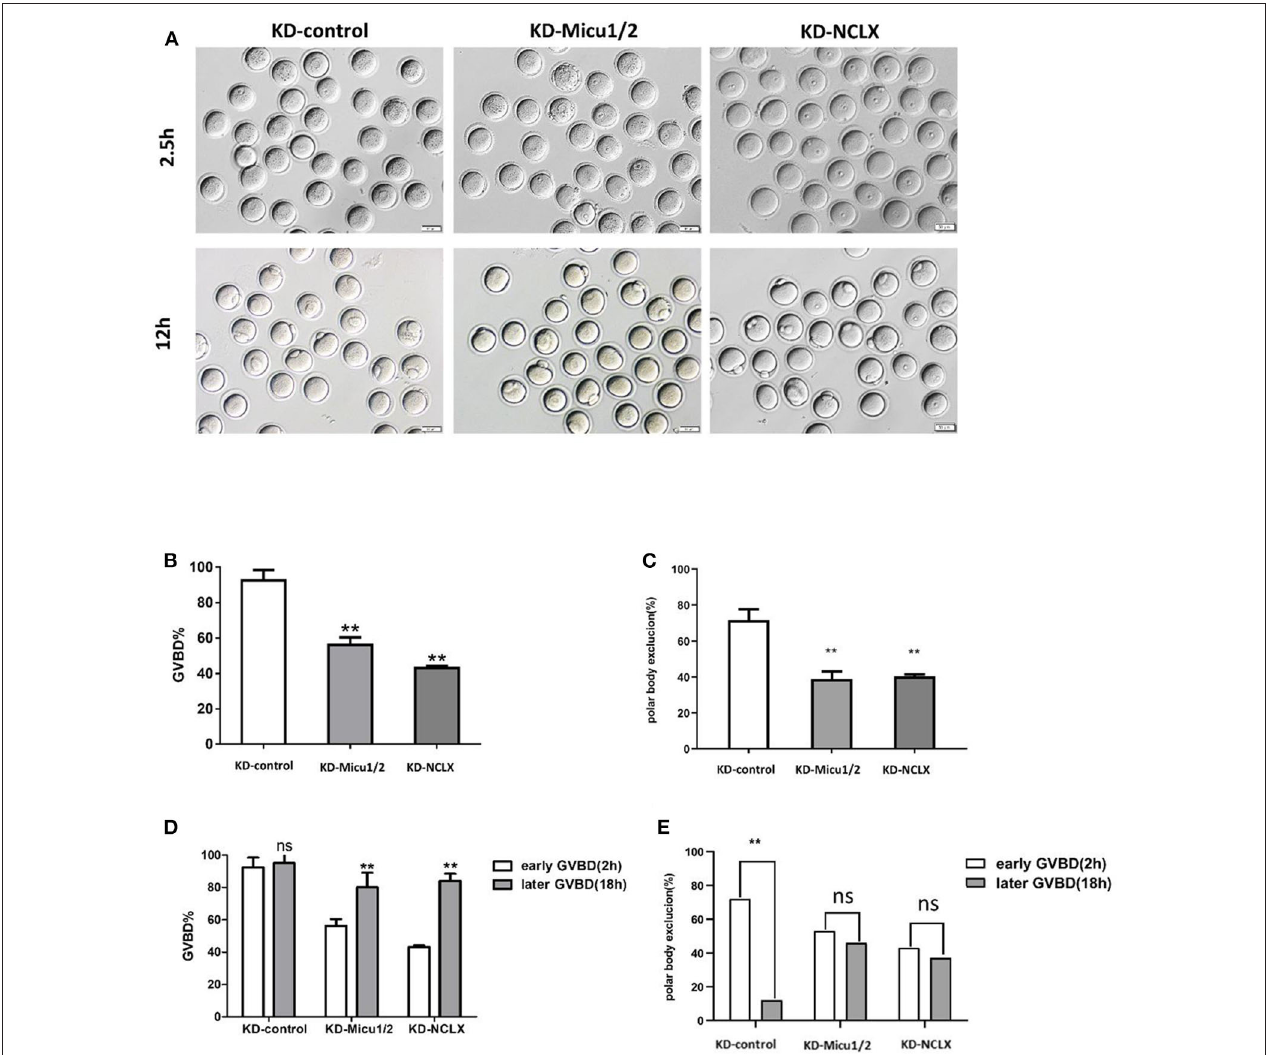
FIGURE 3 | Oocytes maturation is impaired by mitochondrial Ca 2 + overload. (A) Representative images of germinal vesicle breakdown (GVBD) (2.5h) and the first polar body (PB1) (12h) extrusion oocytes from KD-control, KD-Micu1/2, and KD-NCLX. Scale bar: 50 µ m. (B) The percentage of oocytes that successfully progressed to the GVBD during in vitro culture in 2.5h ( n = 158 for KD-control, n = 146 for KD-Micu1/2, and n = 132 for KD-NCLX). (C) The percentage of oocytes that successfully extracted the first polar body during in vitro culture in 12h ( n = 115 for KD-control, n = 107 for KD-Micu1/2, and n = 98 for KD-NCLX). (D) Percentage of germinal vesicle breakdown (GVBD) at 2 and 18h after milrinone removal (Early GVBD n = 103 for KD-control, n = 43 for KD-Micu1/2, and n = 45 for KD-NCLX; Late GVBD n = 5 for KD-control, n = 67 for KD-Micu1/2, and n = 78 for KD-NCLX). (E) Polar body extrusion rate of Early or late GVBD: respectively, before or after 2h after milrinone removal. (Early GVBD n = 72 for KD-control, n = 53 for KD-Micu1/2, and n = 43 for KD-NCLX; Late GVBD n = 12 for KD-control, n = 46 for KD-Micu1/2, and n = 37 for KD-NCLX). Student’s t- test and one-way ANOVA were utilized for statistical analyses. ** P < 0.01. ns, non-significant ( P > 0.05). Error bars indicate SEM.